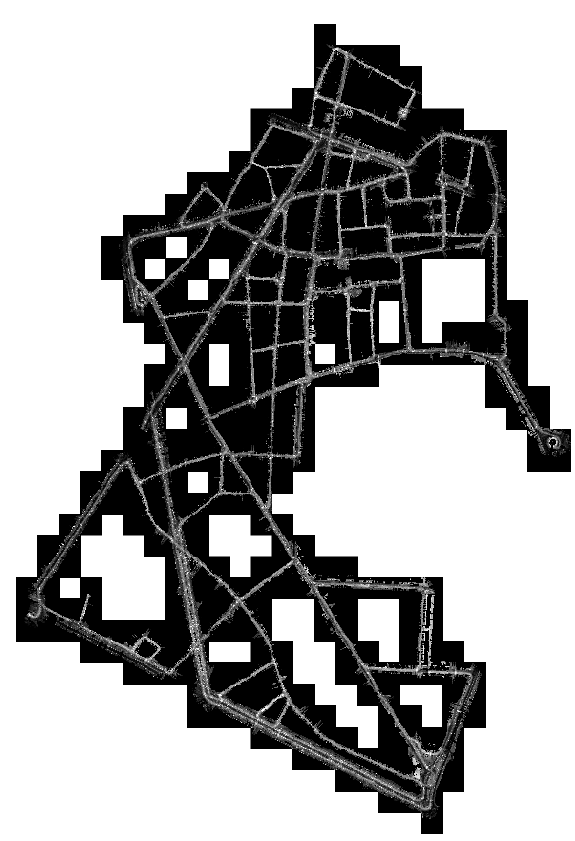
Figure 3: Mobile laser scan reflectance projected into the 412 tiles of our area of study. A single tile is shown on Figure 4